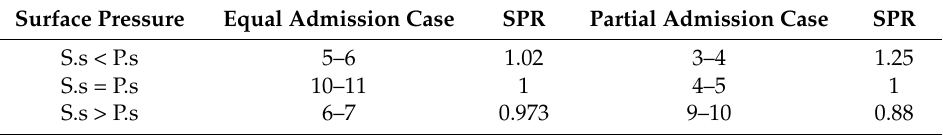
Table 4. The strategy of passages selection and their surface pressure ratio (SPR) number.